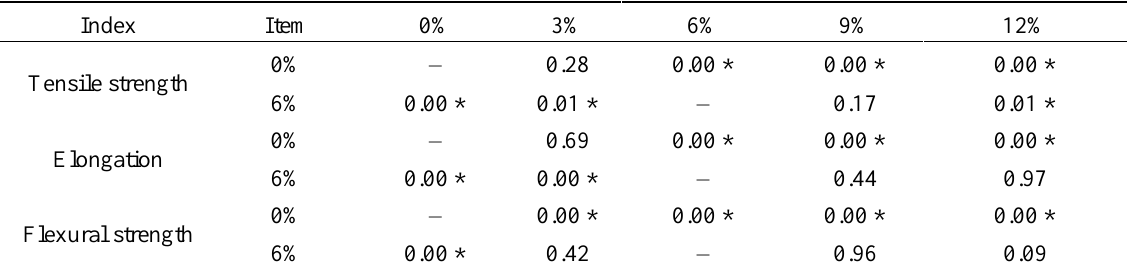
Table 1. t -Test of the experimental